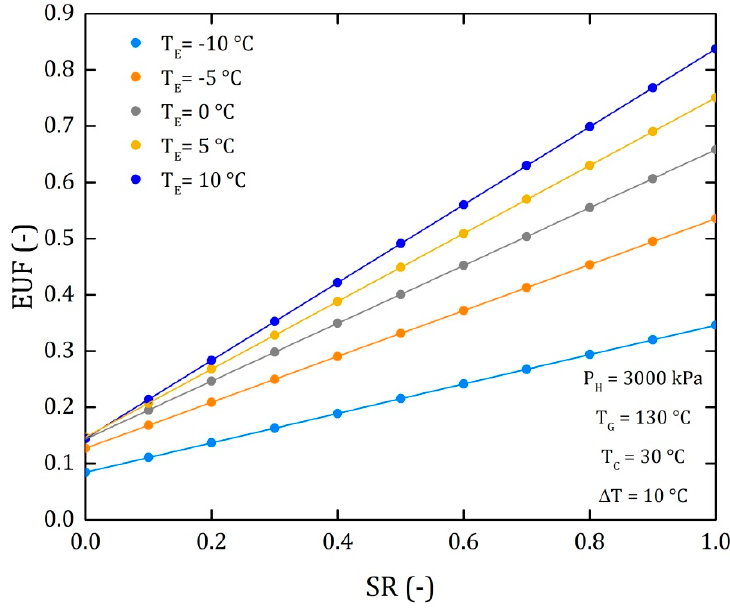
Figure 10. EUF a function of SR for Model III for different evaporator temperatures.